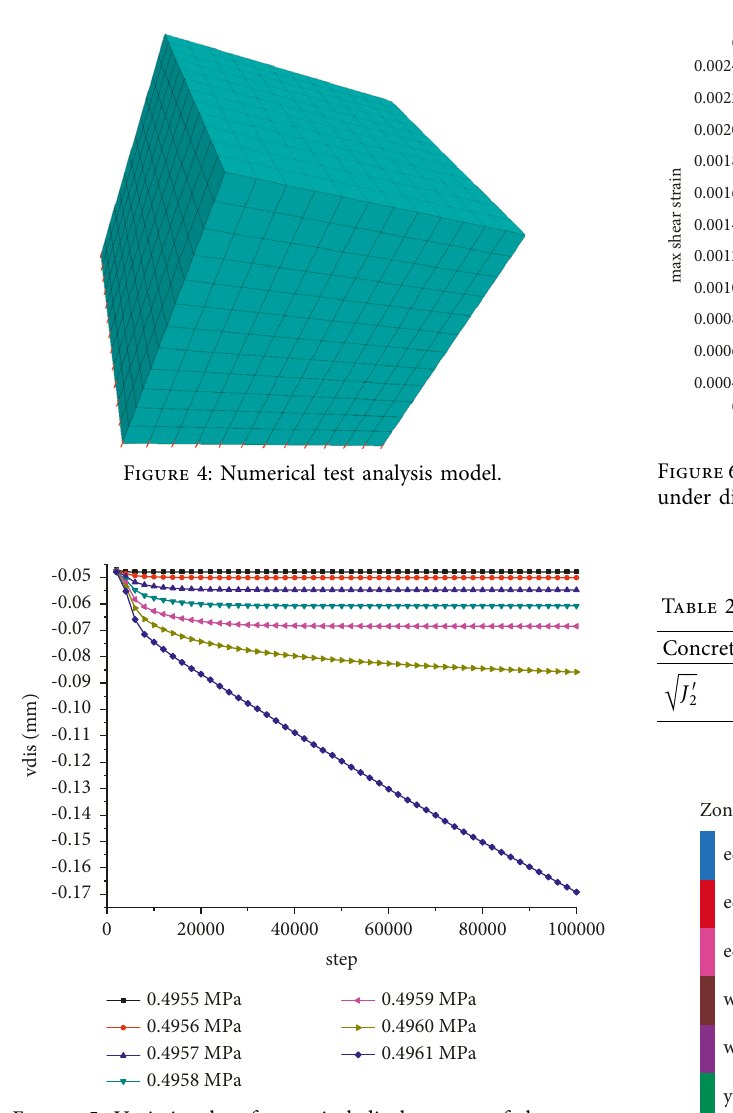
Figure 5: Variation law for vertical displacement of the center point of equivalent rock block under different loads.